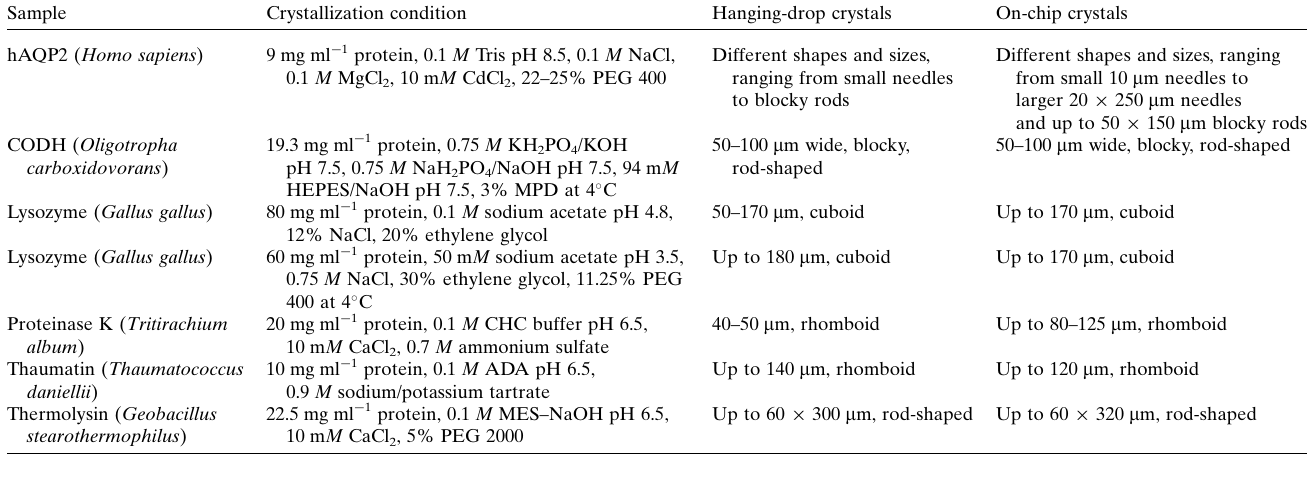
Table 1 Size comparison of crystals grown via conventional hanging-drop experiments versus crystals grown on Roadrunner II chips using the same crystallization condition. In all cases protein solutions were mixed with precipitant solutions in a 1:1 ratio. The volumes used for the drop and the reservoir were 6 and 500 m l for the hanging- drop experiments and 100 m l and 5–7 ml for the on-chip crystallization experiments, respectively. Unless otherwise stated, crystallization experiments were performed at room temperature.